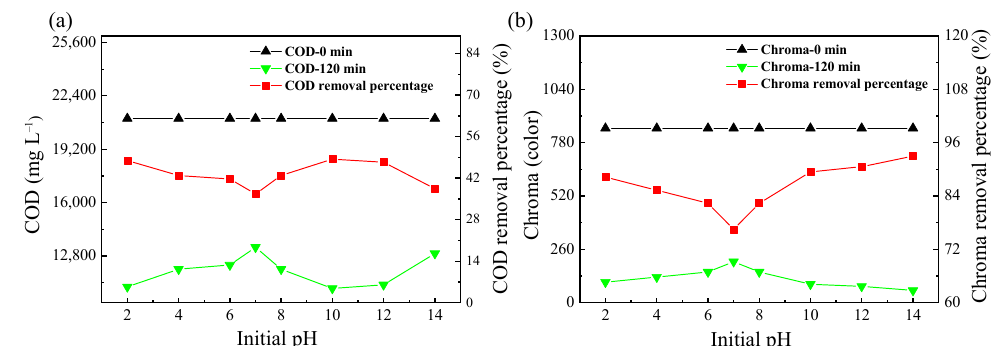
Figure 1. Influences of initial pH on ( a ) COD and ( b ) chroma removal at 2 h. Reaction conditions: Al scrap dosage, 100 g L − 1 ; Al/AC mass ratio, 1:2; rotate speed, 150 r min − 1 .